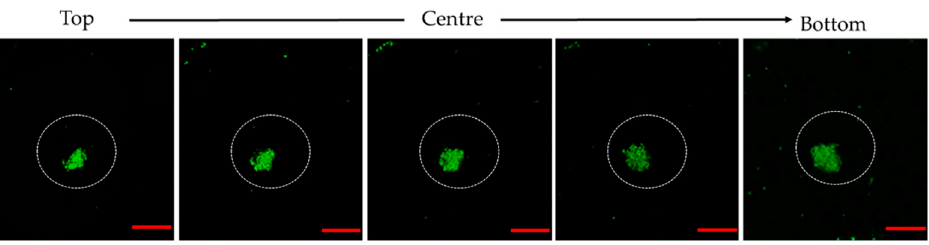
Figure 6. Cluster size with respect to storage days. Bars represent mean ± SEM taken from 3 inde ‐ pendent experiments. A total of 10 droplets were measured for each experiment (N = 10).